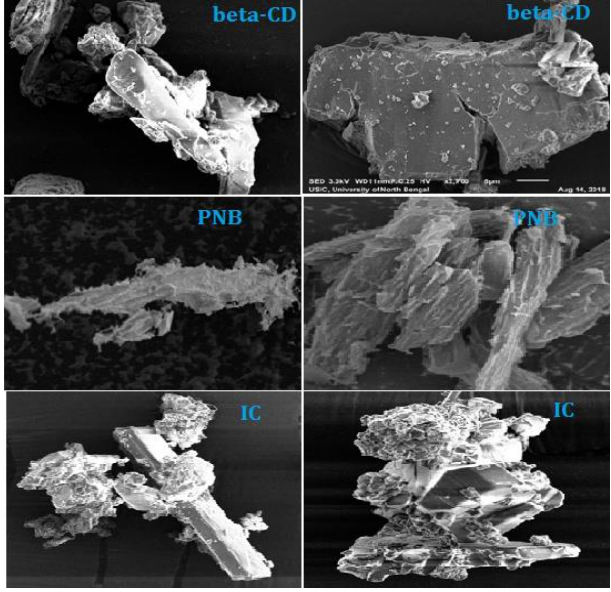
Figure 10. Scanning electron microphotographs (a) β-CD (b) PNB (c) PNB- β-CD inclusion